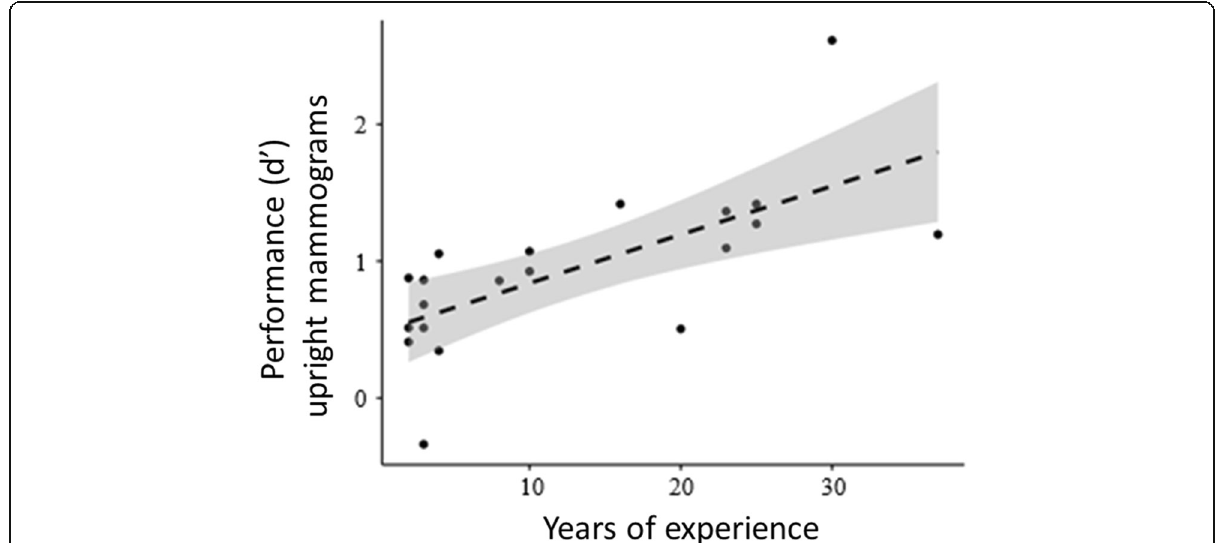
Fig. 4 Performance d ’ scores of upright mammogram stimuli across years of radiology experience